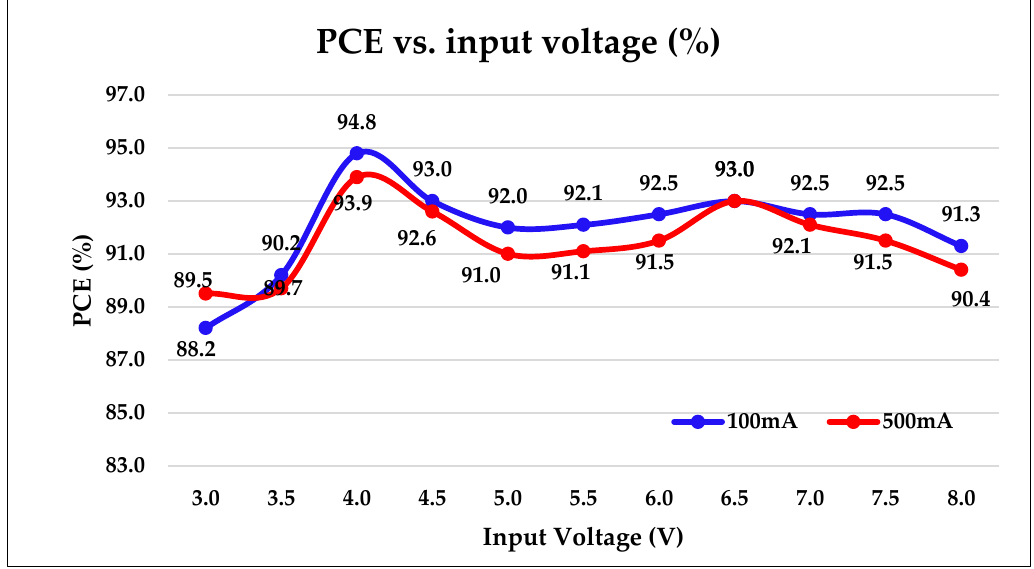
Figure 13. Power conversion efficiency of the proposed buck-boost DC–DC converter.